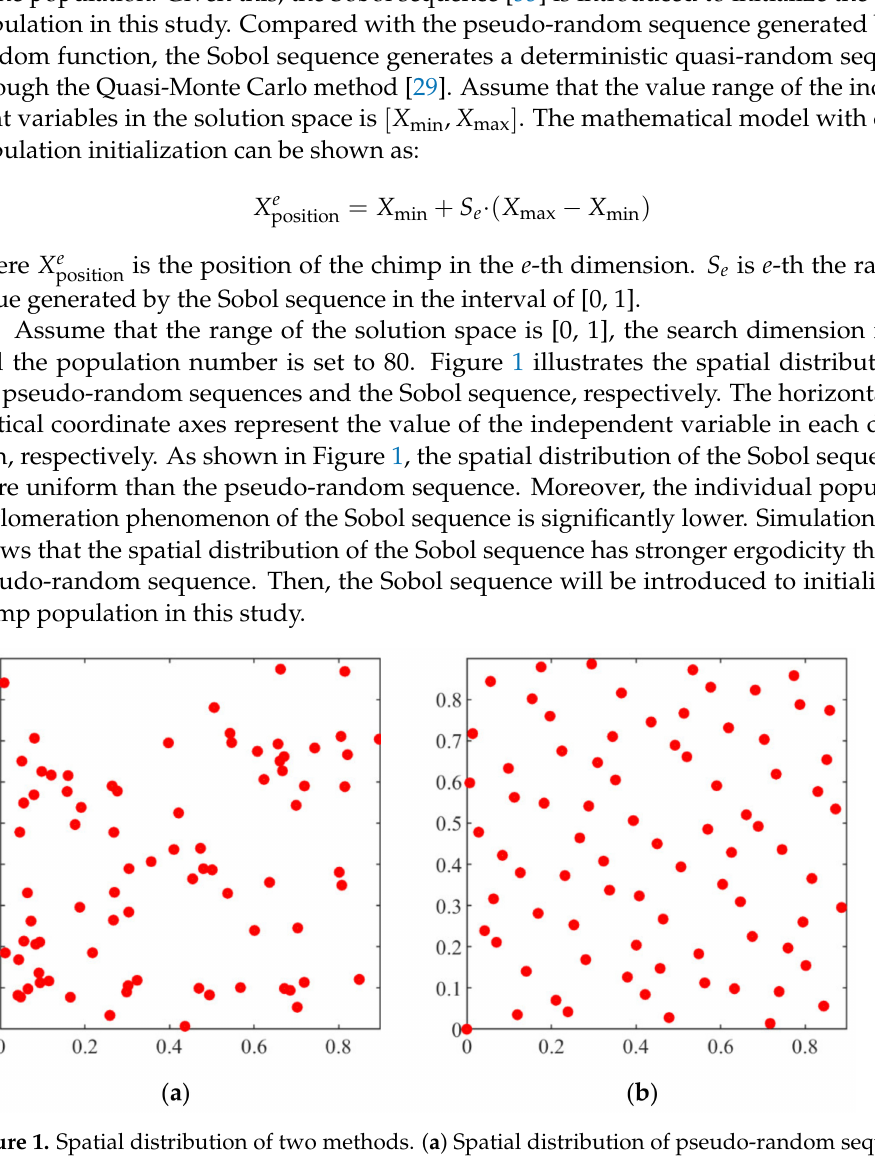
Figure 1. Spatial distribution of two methods. ( a ) Spatial distribution of pseudo-random sequences. ( b ) Spatial distribution of Sobol